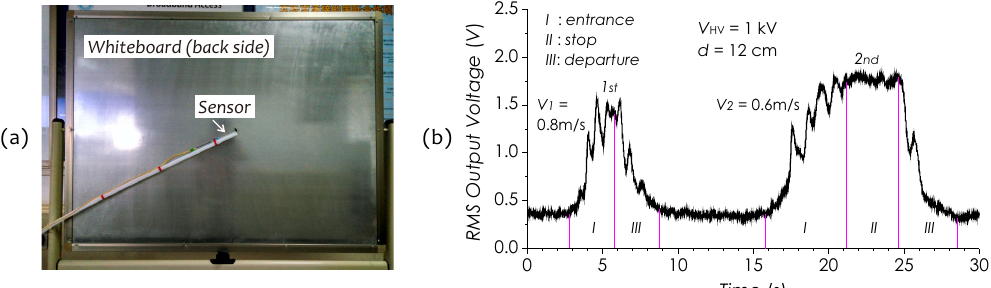
Figure 20. ( a ) A photograph of experimental arrangement used for human presence sensing. ( b ) RMS output signal trace recorded during a 30-s